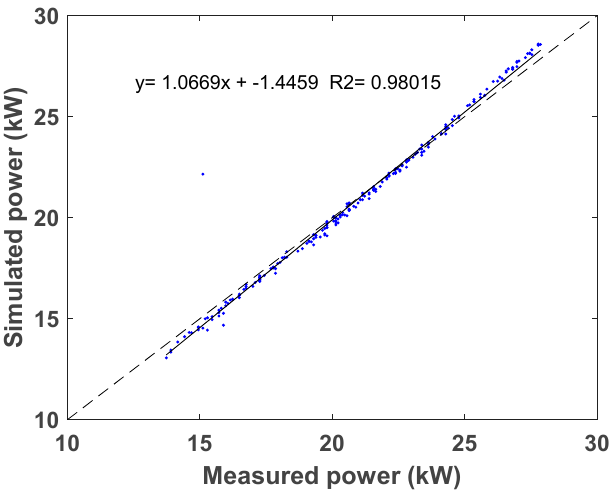
Figure 3. Comparison between the VFD efficiency supplied by the manufacturer and the output power measured.